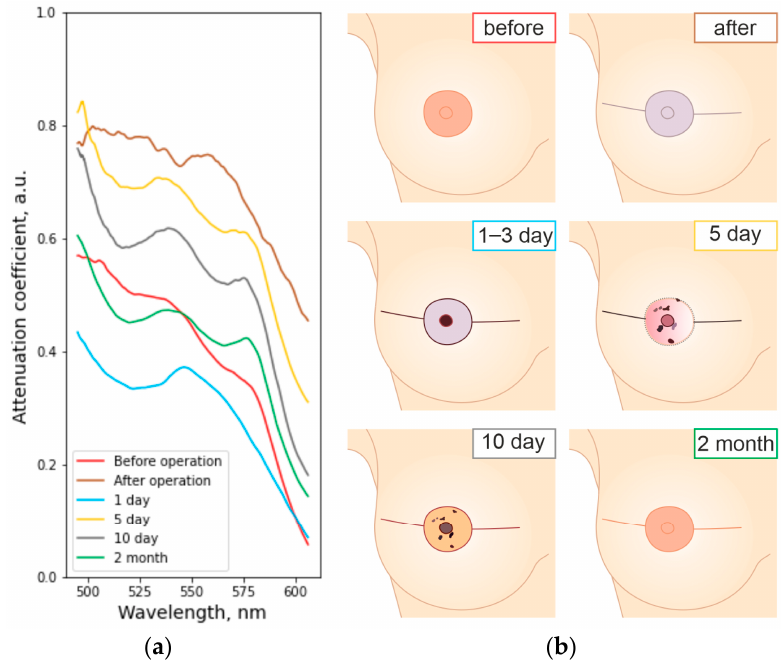
Figure 6. ( a ) The attenuation coefficient spectra obtained from areola. ( b ) View of the operated tissues of the NAC area, where optical-spectral control was performed. Black dots on NAC area is a wounds